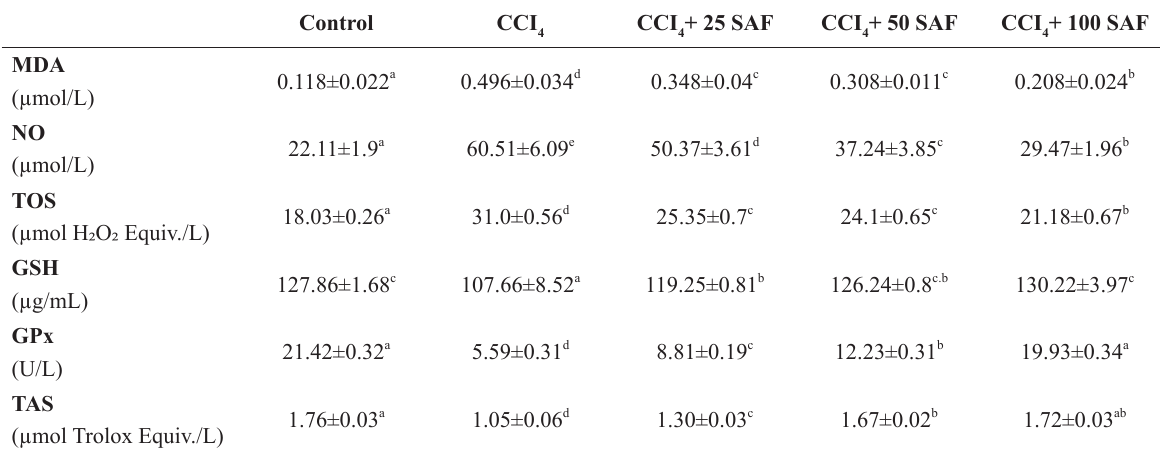
Data are presented as mean ± standard deviation (n = 7). Statistical differences between the experimental groups are expressed with superscript letters (a-e). CCI